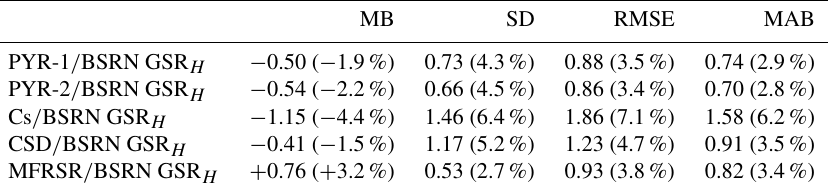
Table 3. Statistics of the comparison between daily GSR H from PYR (Method 1 and 2), CS recorder, CSD recorder and MFRSR with daily